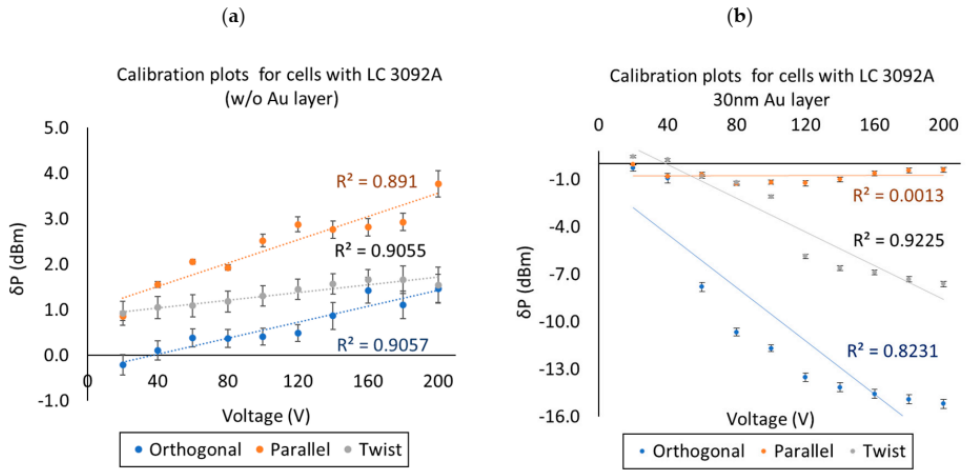
Figure 10. Estimation of the calibration plot for 700 nm. ( a ) cells without gold layer and ( b ) cells with deposited gold